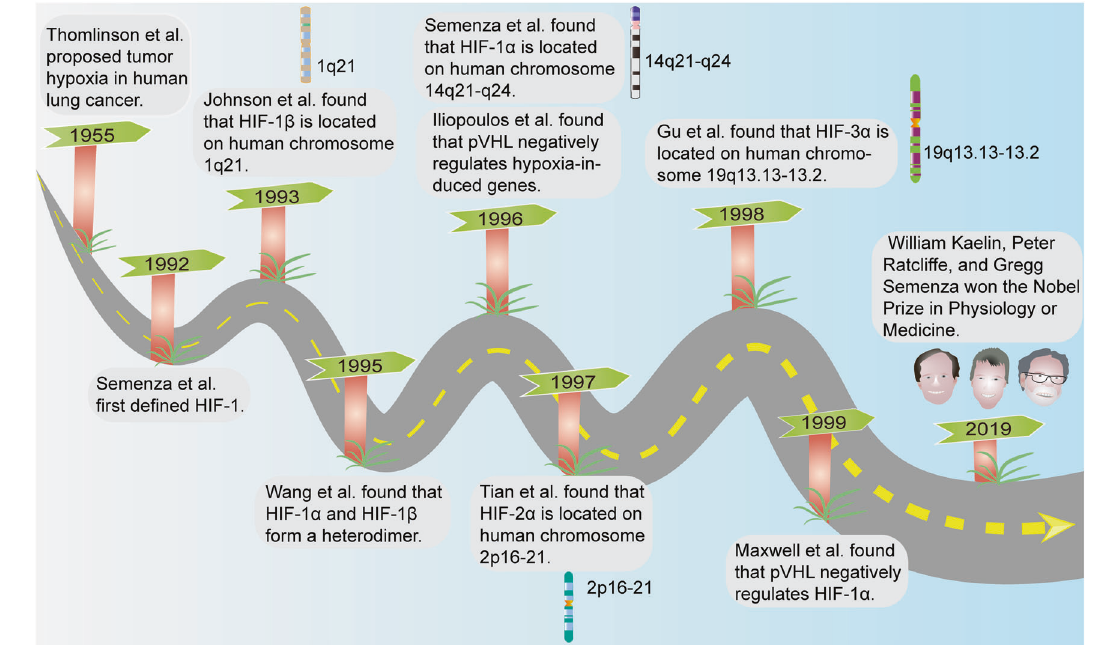
Fig. 1 A historical and chronological fi gure of major events in tumor hypoxia research